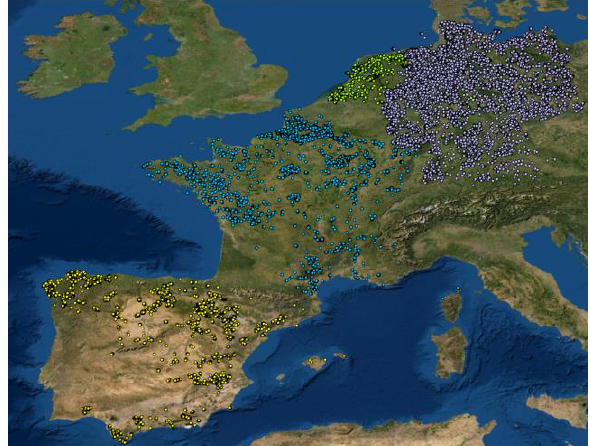
Figure 7 . Windmills extracted from OSM database